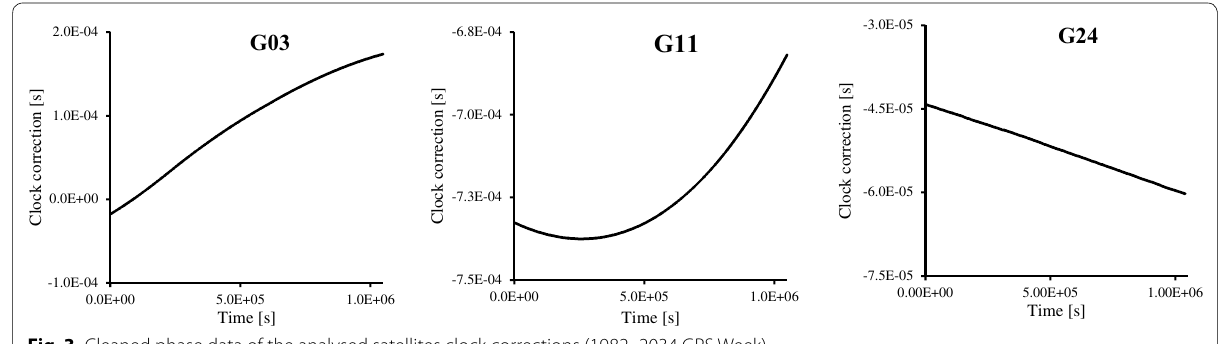
Fig. 3 Cleaned phase data of the analysed satellites clock corrections (1982–2034 GPS